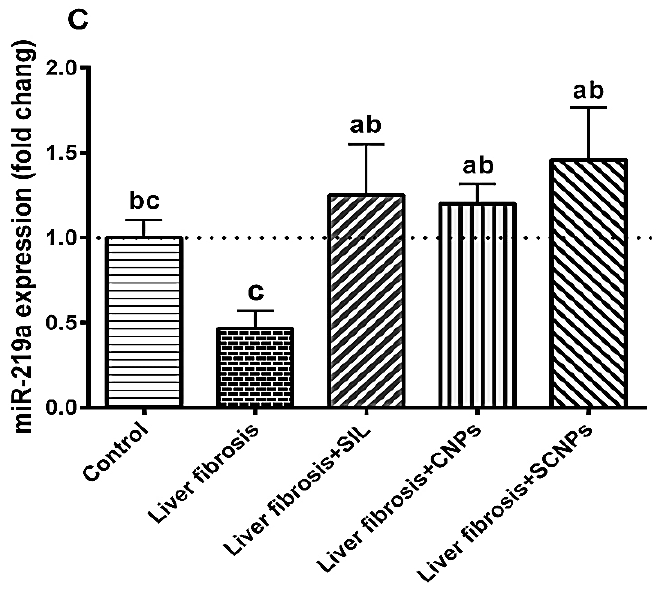
Figure 7. Hepatic expressions of miRNAs: ( A ) miR-22; ( B ) miR-29c; and ( C ) miR-219a. Data are presented as mean ± SD ( n = 6). The means of the groups in the same column with the same superscript letter are not significantly different, while the means with different letters are significantly differed according to the ANOVA test, followed by the post hoc test (Tukey). At p ≤ 0.05, the difference was statistically significant.